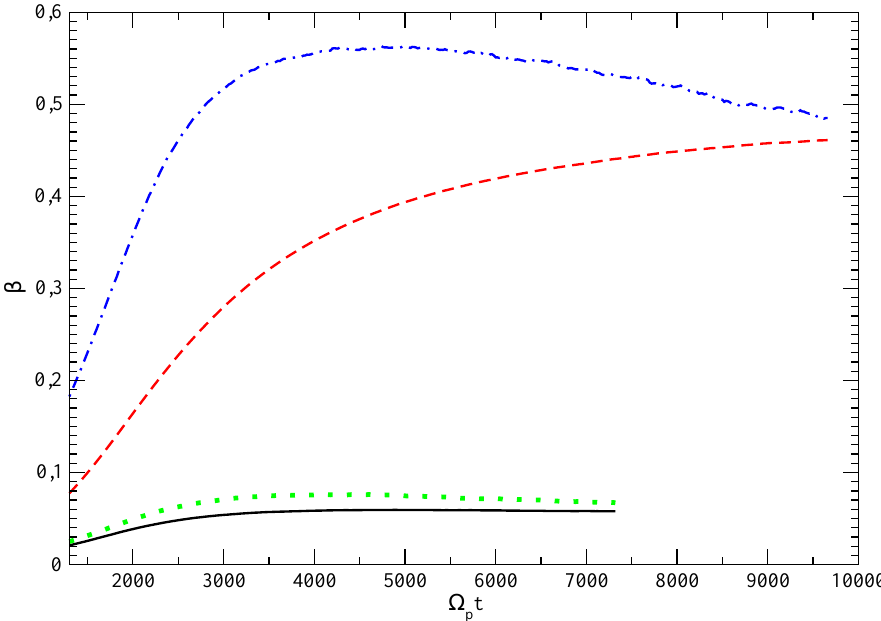
Fig. 1. Time dependence of the inclination angle β , in radians, at the stream impact position r = 1. See the text for a description of particular